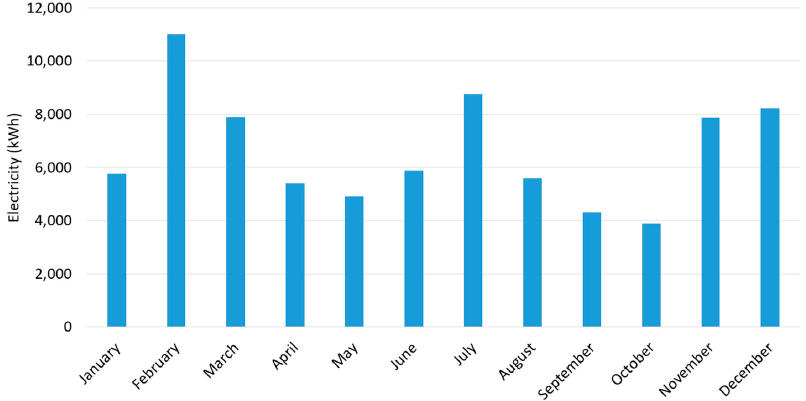
Figure 4. Monthly electricity consumption of the complete station in 2014.